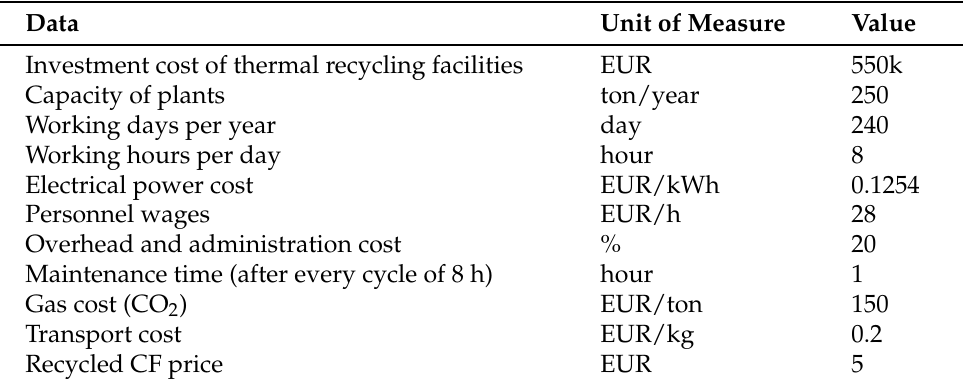
Table 12. Characteristics and costs related to thermal recycling. Electricity power costs were taken from [87]. Personnel wages data were taken from